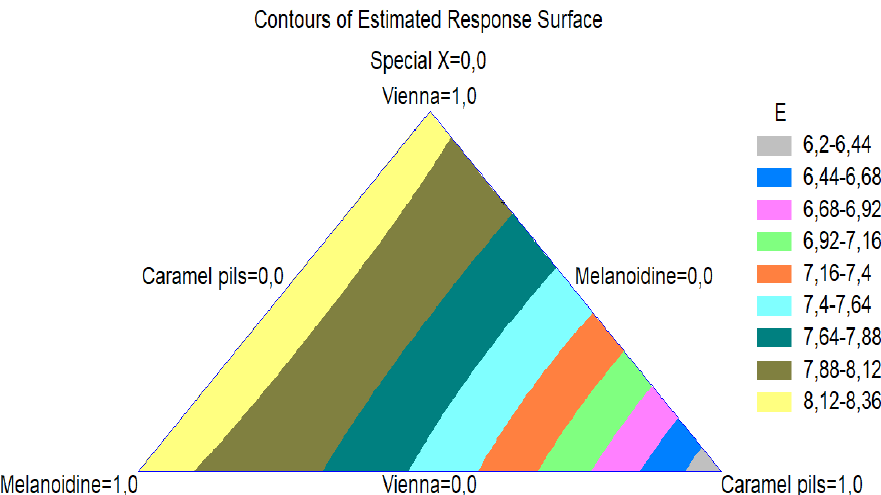
Figure 3. Effect of mixture composition on the wort extract. (the “,” character represents a decimal point).